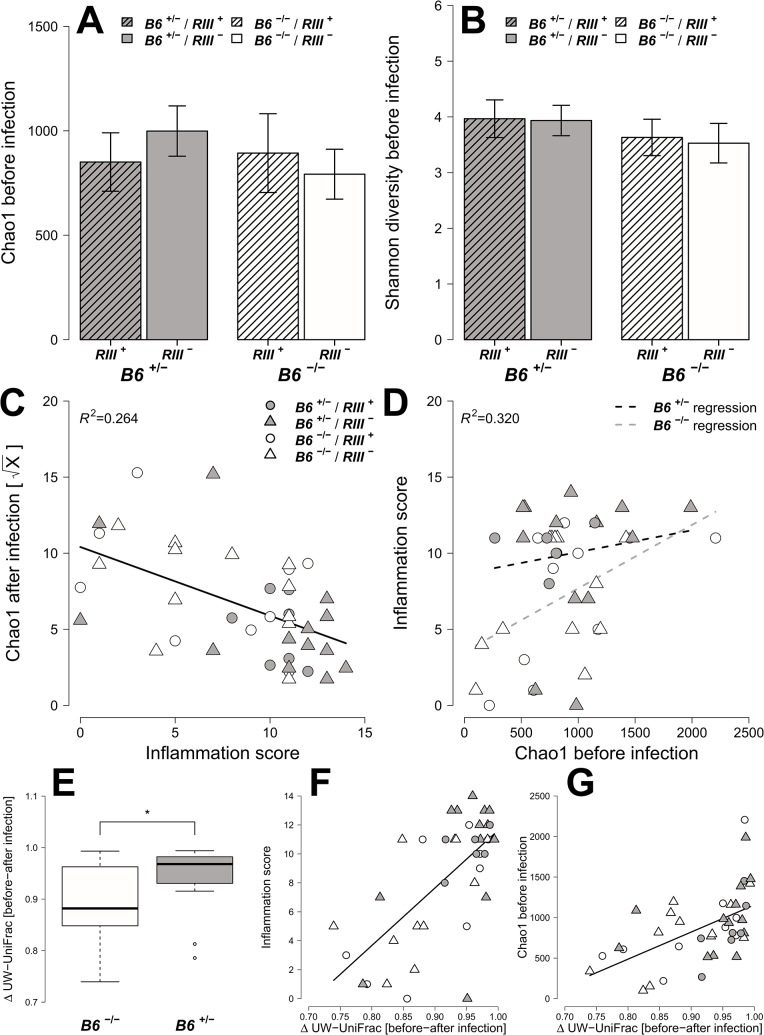
Analysis of microbial alpha diversity among genotypes and their association with intestinal inflammation.Microbial diversity was estimated from 97% species level OTUs and focused on the mean species richness (A; Chao1), and mean abundance based diversity (B; Shannon H), in the untreated animals. (C) The bacterial species richness is (i) decreasing with increasing inflammation (F
1,22 = 14.2123, P = 0.0011; LMM), (ii) but highly predictive of inflammation with differences among B4galnt2 genotypes (D; Chao1 F
1,21 = 9.8274, P = 0.005, B6: F
1,21 = 9.2976, P = 0.0061, see also Table 2). The predictive power of alpha diversity for the outcome of infection is significantly improved by incorporating the B6 genotype (Chao1: R
2
LR = 0,320, ΔAIC = -5.936, LR = 7.9360, P
LR-Test = 0.0048; Shannon H: R
2
LR = 0,271, ΔAIC = -6.1811, LR = 8.1811, P
LR-Test = 0.0042; NTI: R
2
LR = 0.2625, ΔAIC = -8.8842, LR = 10.8842, P
LR-Test = 0.001). The turnover of bacterial communities (Δ unweighted UniFrac) over the course of the experiment is strongest in animals expressing B4galnt2 in the epithelium (E; Z = -2.3213, P = 0.01978; Wilcoxon test via Monte-Carlo resampling), and is highest in animals with strong inflammation (F; ρ = 0.5894, P = 0.00005; Spearman rank correlation). The community disturbance is also highest in animals with a high species richness before treatment (G; ρ = 0.6040, P = 0.000042; Spearman rank correlation; # P < 0.100, * P < 0.050, ** P < 0.010, *** P < 0.001, error bars indicate SEM; only results of best models are shown and pairwise tests are indicated).